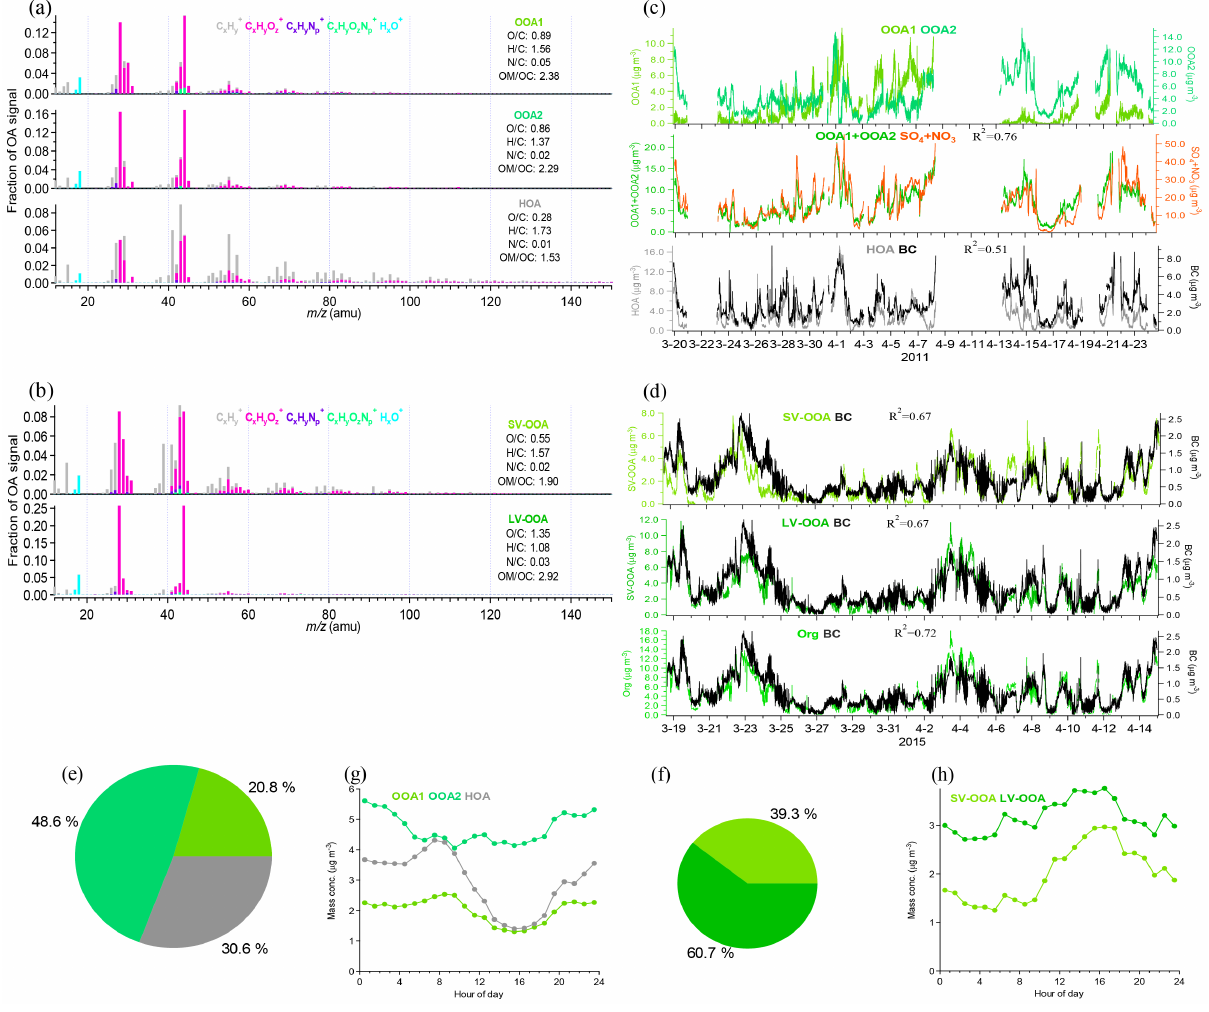
Figure 6. Mass spectrum profiles of the OA components at (a) NCB and (b) SCB identified by PMF. The time series of the OA components at (c) NCB and (d) SCB and other relevant species, the averages of the OA compositions at (e) NCB and (f) SCB, and the diurnal patterns of the OA components at (g) NCB and (h)